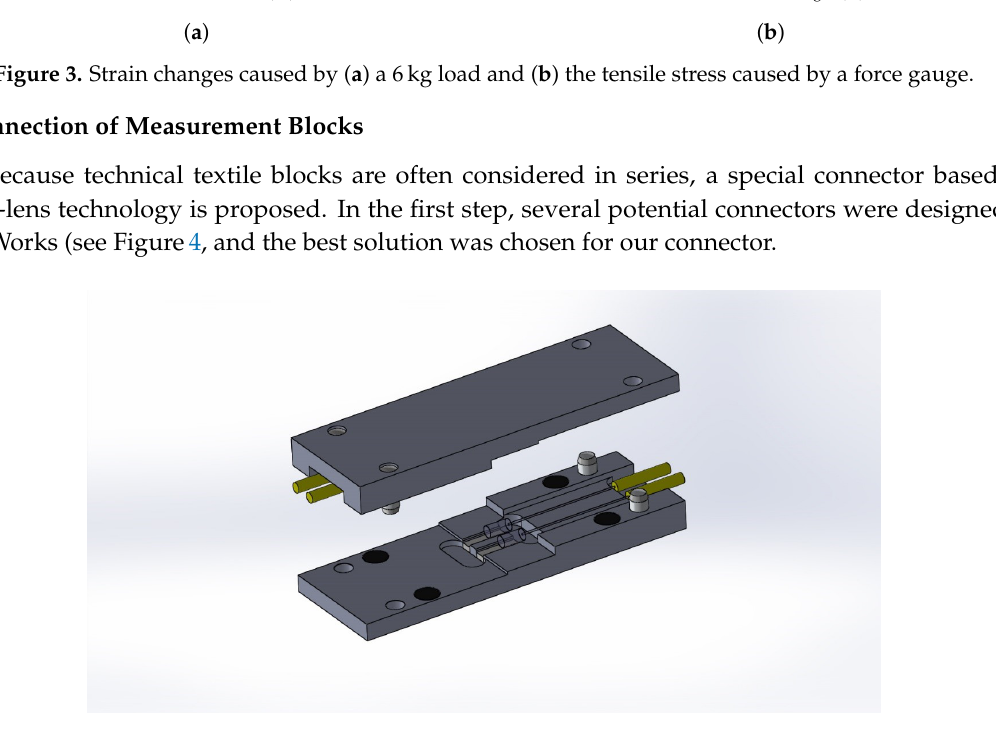
Figure5. Influenceofthetemperaturetoattenuationoftheconnector. Figure 3. Strain changes caused by ( a ) a 6kg load and ( b ) the tensile stress caused by a force gauge.